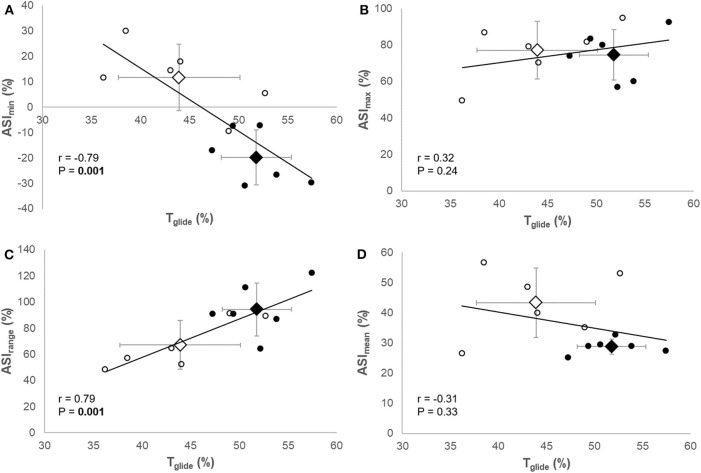
Correlations between the relative glide time (Tglide) and minimum value [ASImin
(A)], maximum value [ASImax
(B)], range [ASIrange
(C)], and mean value [ASImean
(D)] of the asymmetry index during the gliding phase. Circles represent individual datapoints and diamonds represent the mean ± SD of the group (open: regional level, solid: national level).